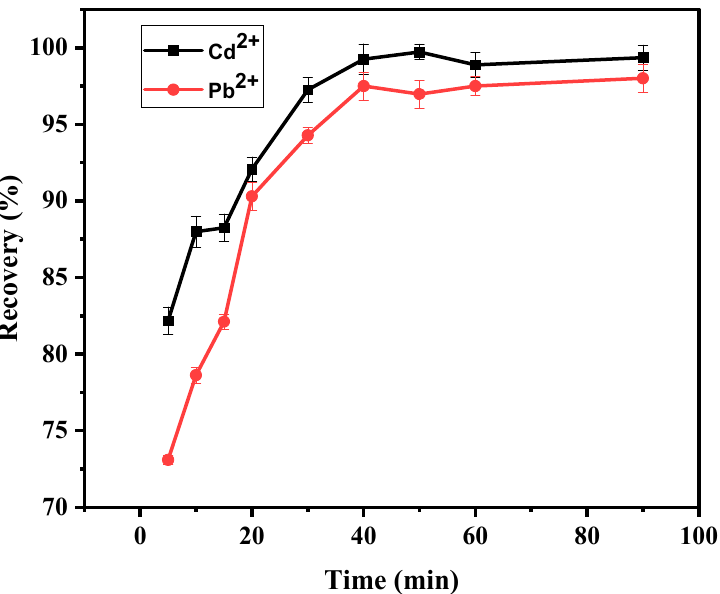
Figure 8. Effect of contact time on the adsorption of Cd 2+ and Pb 2+ using BPAC@Al 2 O 3 @chitosan material at an AM of 0.1 g, pH of 6, and initial concentration of 20 mg L − 1 .